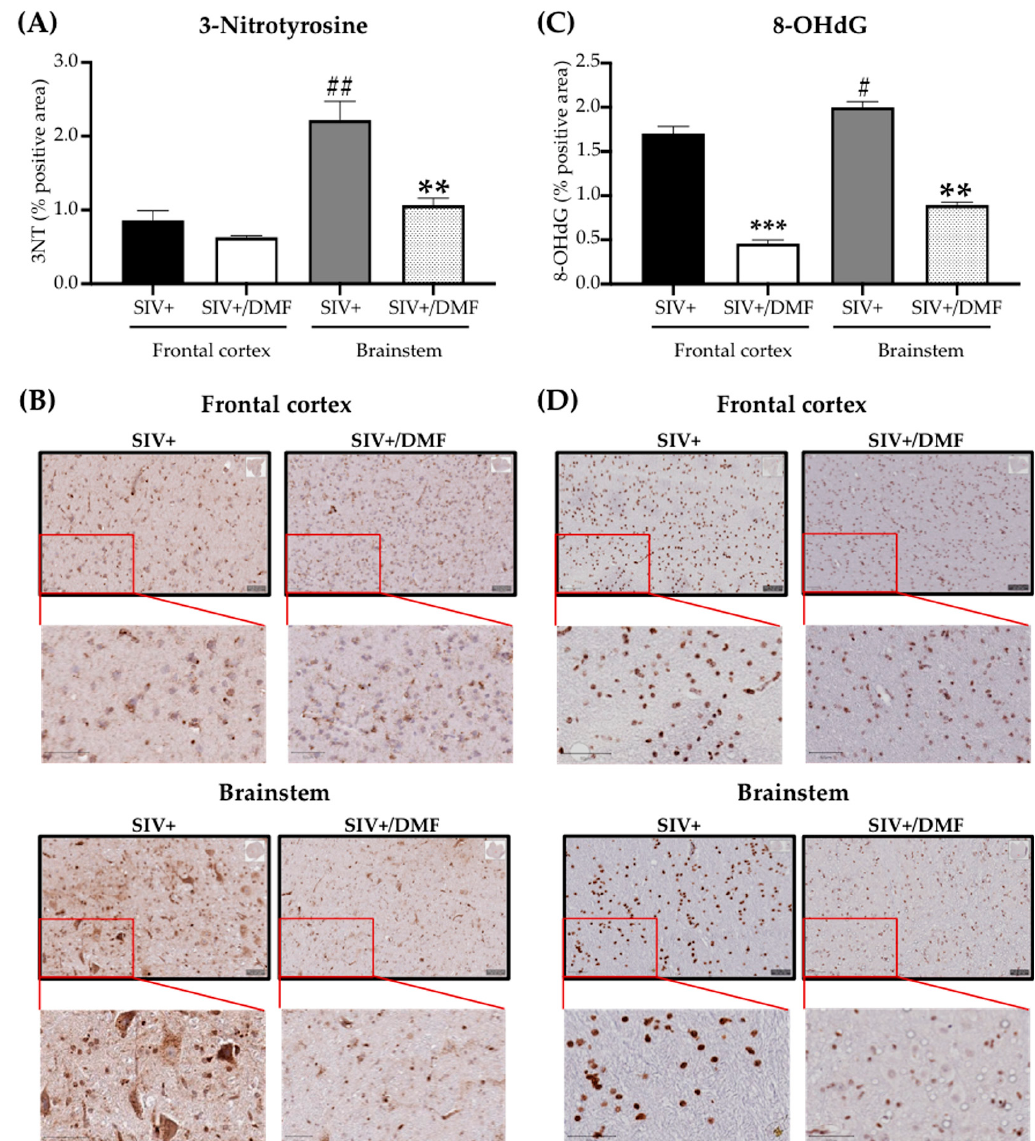
Figure 6. DMF treatment was associated with the reduced expression of markers of DNA and protein oxidation in the frontal cortexes and brainstems of SIV-infected macaques. ( A ) Quantification of 3NT (oxidized proteins) in the frontal cortex (left) and brainstem (right) showed reduced expression in the brainstem with DMF treatment. The 3NT labeling was significantly higher in the brainstem compared to the frontal cortex in SIV infection (statistical analysis was done with